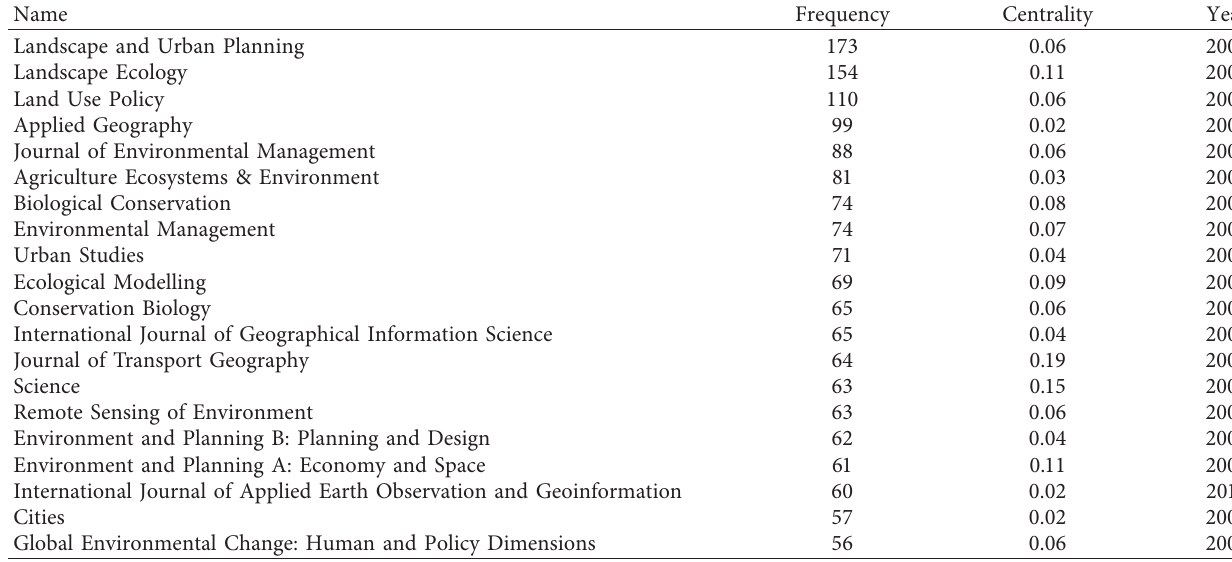
Figure 1: Keywords’ co-occurrence network. The node represents a keyword, the size of the node indicates the number of occurrences, and the line thickness of the two nodes represents the degree of connection. Table 3: Statistical on journal